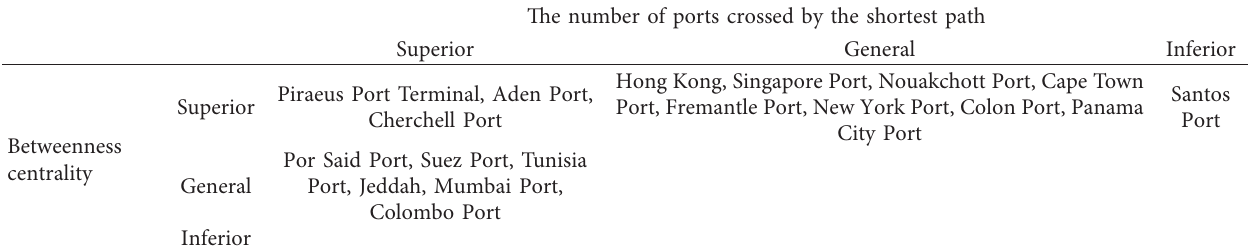
Table 8: A joint coverage matrix of strategically important “superior” ports.